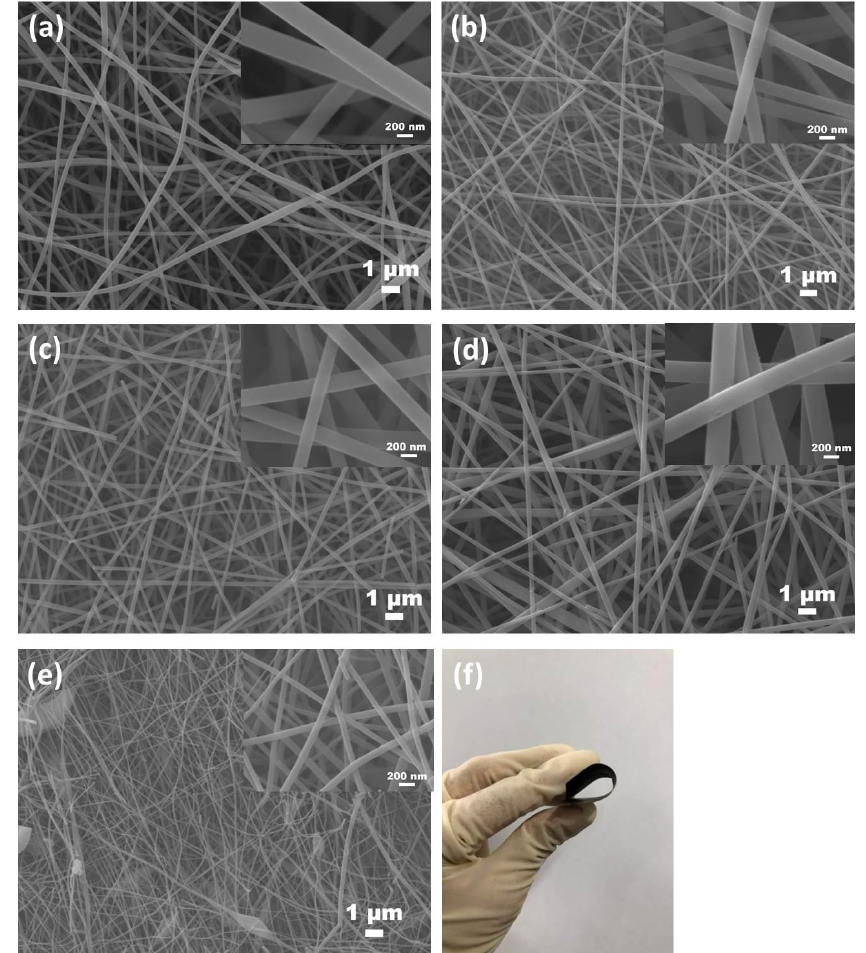
Figure 1. SEM images of ( a ) ACF-0; ( b ) ACF-3.9% PDPP; ( c ) ACF-6.4% PDPP; ( d ) ACF-10.3% PDPP; ( e ) ACF-12.9% PDPP; and ( f ) optical image of ACF-10.3%